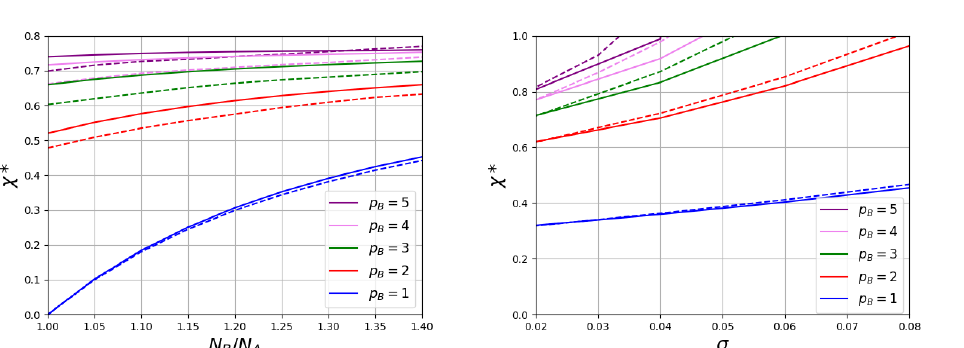
Figure 5. The values of transition points χ ∗ . ( The left picture ) shows the impact of the ratio of polymeriza- tion degrees of responsive and non-responsive chains at σ = 0.01. ( The right picture ) shows the impact of grafting density σ at N B / N A = 1.2. The polymerization degree of non-responsive polymer is varied: N A = 100 (solid lines) and N A = 200 (dashed lines). Kuhn lengths of responsive polymer is varied p B and constant for non-responsive polymer p A =